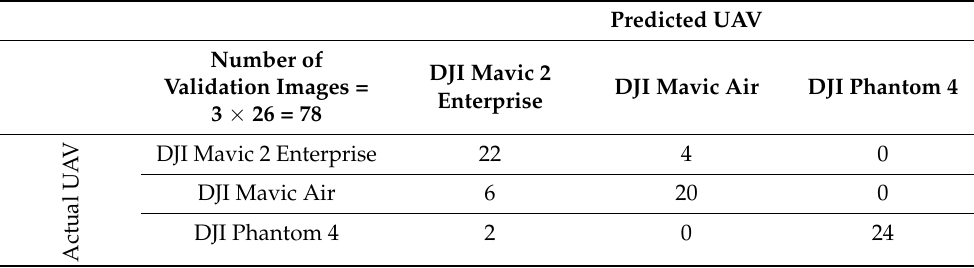
Table 4. Confusion Matrix for Prediction of Test Images Using Trained Resnet-18 Model.